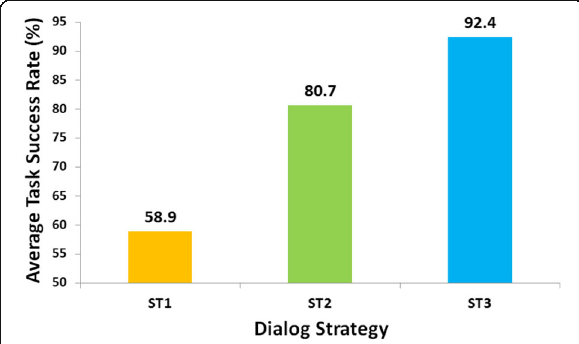
Fig. 13 Evaluation results and comparison of the average task success rates for 20 dialogs with three dialog strategies (ST1~ST3)